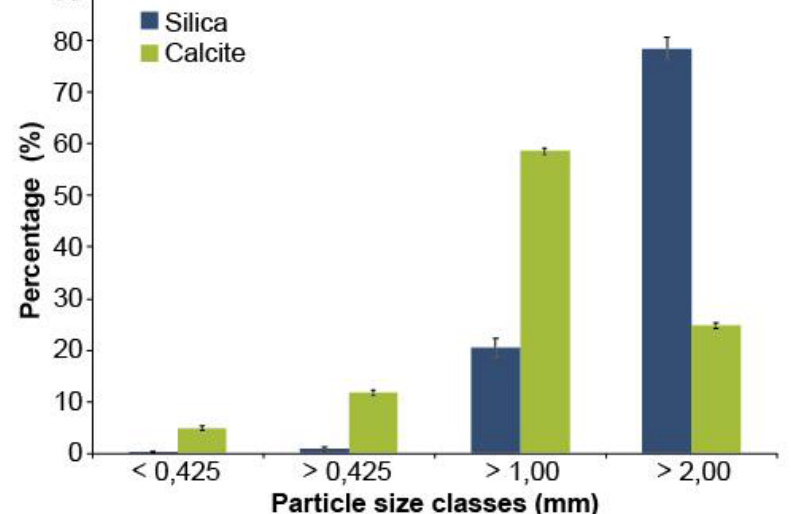
Figure 1. Particle size distribution of silica and calcite used as covering material during the production of white spruce seedlings ( n = 3 composite samples of each covering material. The error bars represent the standard error).